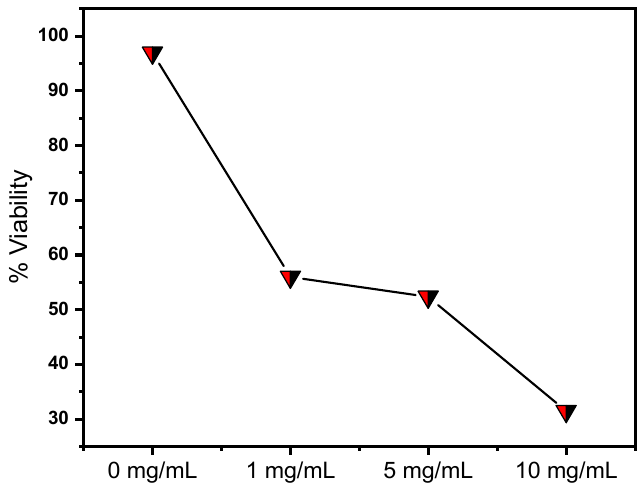
Figure 10. % Cell viability measured using a WST-8 assay after 24 h exposure to constructs (37 °C, 5% CO 2 ). Viability was calculated using the following formula: [A549 (sample)/A549 (control)] × 100.